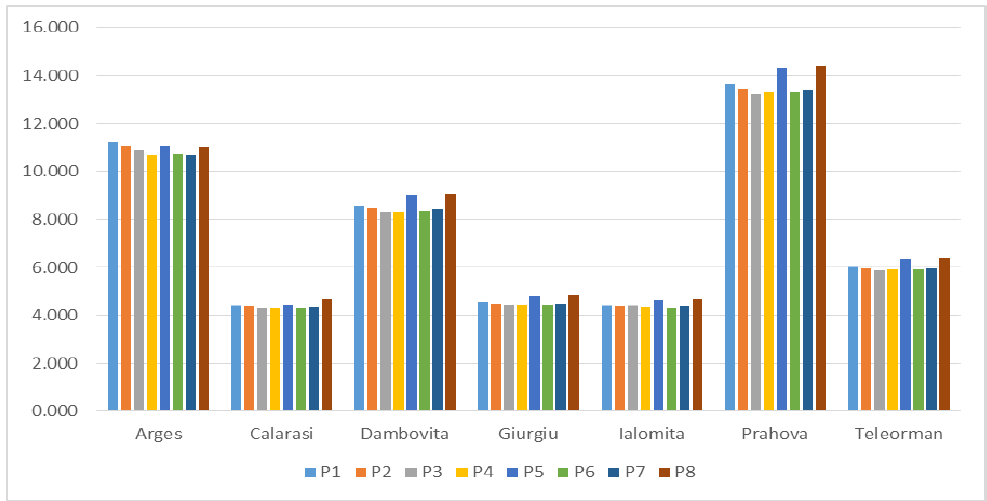
Figure 8. LCC at county level for the minimum scenario (bln.euro).